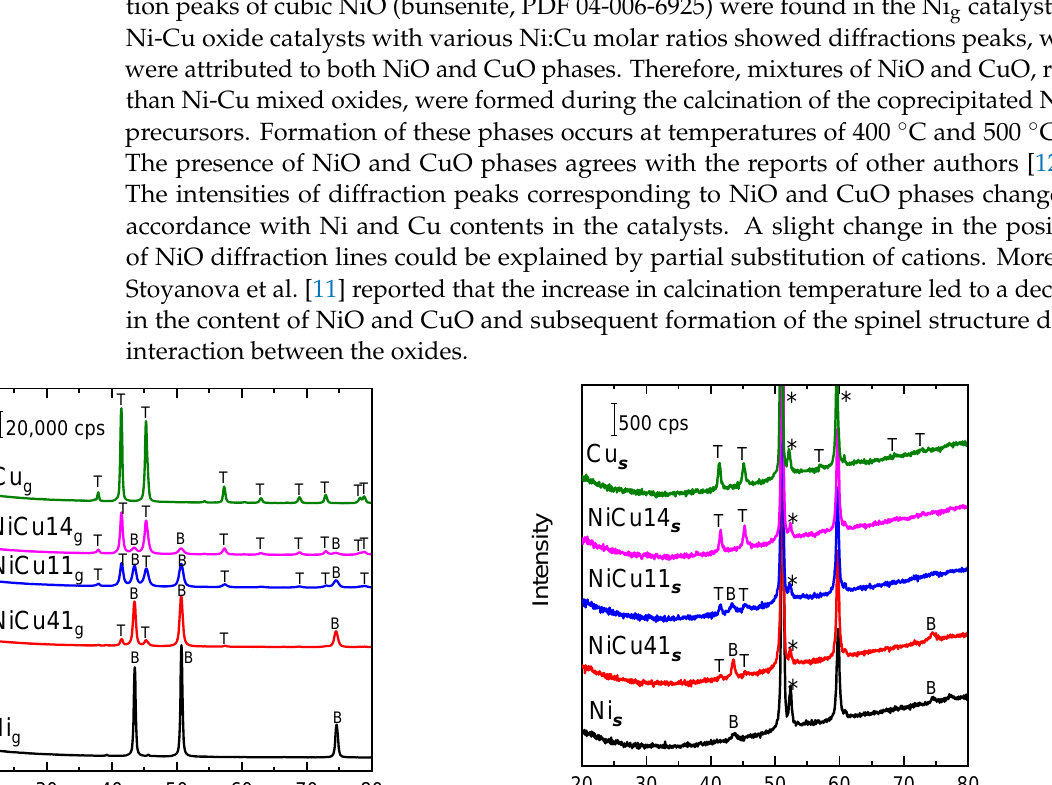
Figure 1. SEM images of the Ni-Cu oxide layers with various Ni:Cu molar ratios deposited on stain- less steel meshes by plasma jet sputtering.